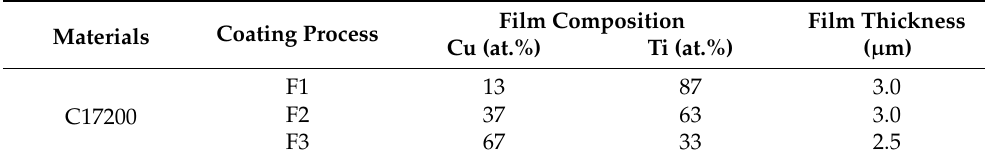
Table 4. The composition and thickness of the fabricated Cu-Ti films formed by magnetron sputtering on C17200 Cu alloys.